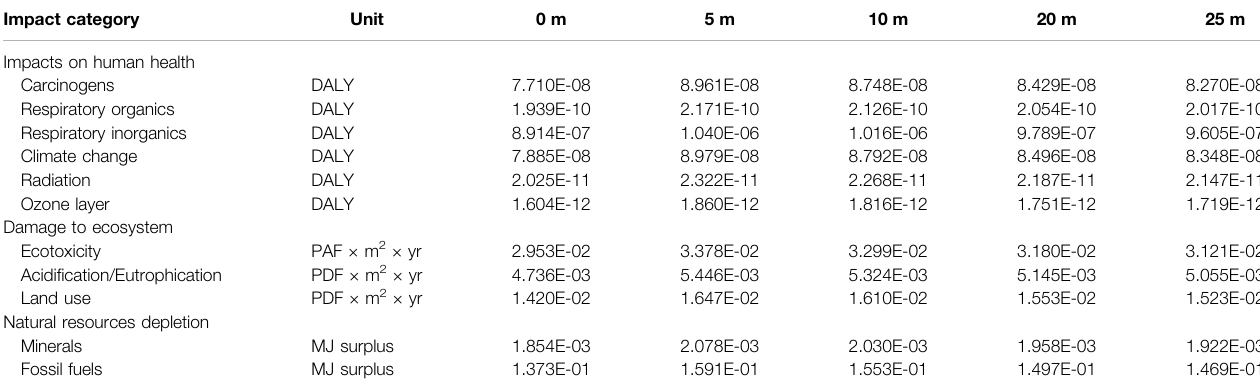
TABLE 2 | Life cycle impact assessment results (characterized results).